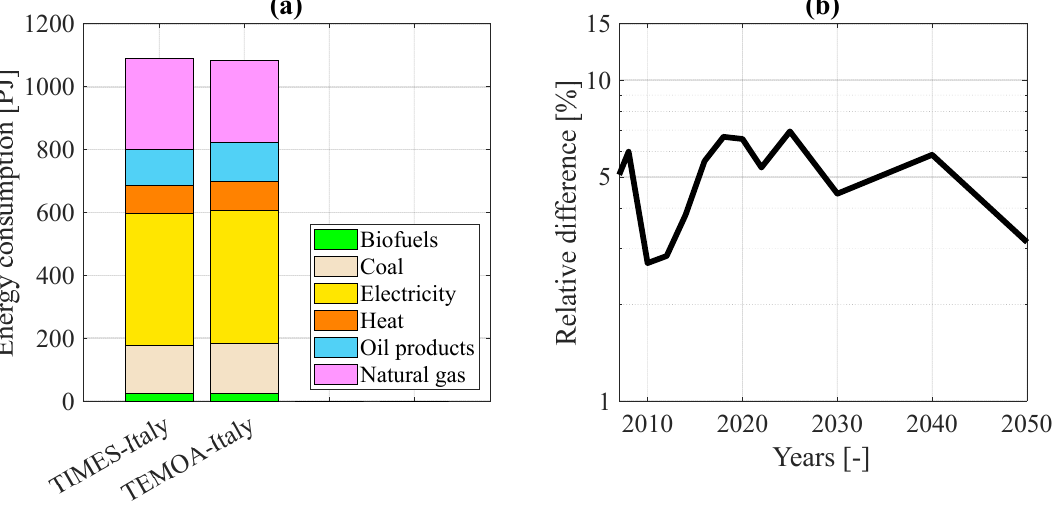
Figure 7. Comparison between the optimal industrial energy mix: ( a ) composition in 2030; ( b ) average relative difference curve along the time.